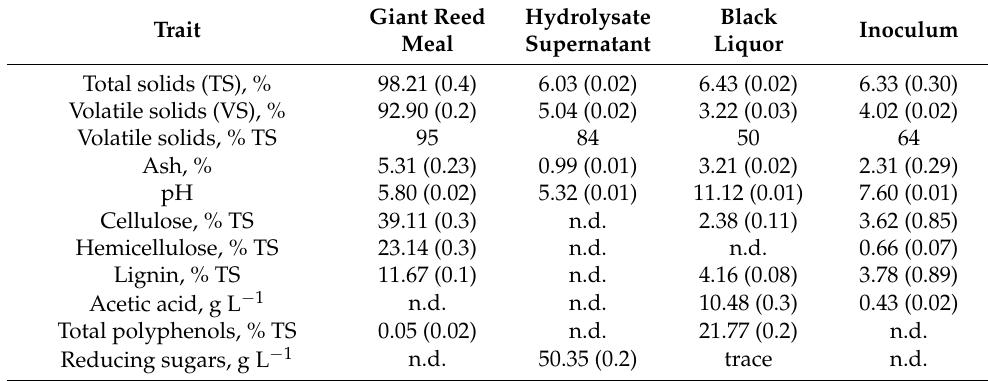
Table 1. Composition of the materials utilised in dark fermentation.